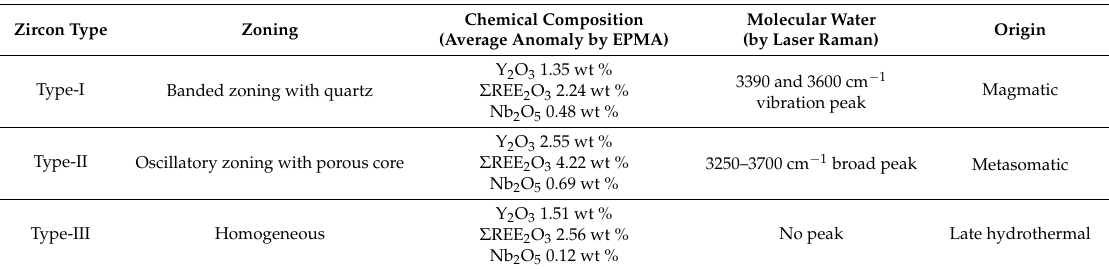
Table 2. Summary of the characteristics of zircon